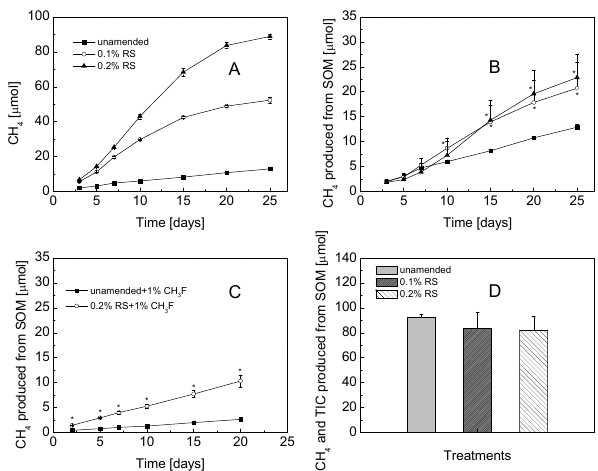
Fig. 4. Production of CH 4 (A) , SOM-derived CH 4 production (B) , SOM-derived CH 4 production in the presence of 1% CH 3 F (C) and total amount of SOM-derived CH 4 and TIC (D) in control soil and treatments with 0.1% or 0.2% 13 C-labeled RS I or II. The RS was applied after 40days of anoxic pre-incubation of rice soil, and then the headspace of all bottles was re-flushed with N 2 . Therefore, “day 0” on the x axis corresponds to the actual date of “day 40” in the entire incubation period. Data are means ± SD ( n = 3). The total amount of SOM-derived CH 4 and TIC were calculated at day 25 after RS application. The differences between control and RS treatments were tested by two-tailed independent t test only in (B) and (D) , indicated by ∗ when P <0.05.